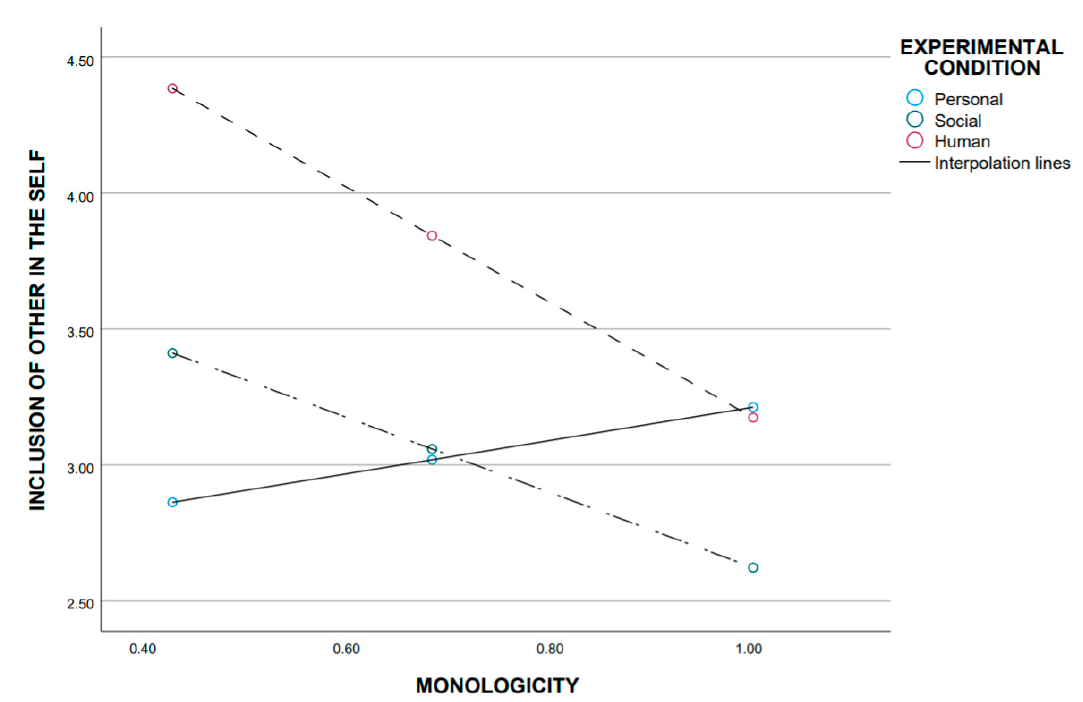
Figure 2. Scatterplot of the relations between monologicity (square root) and inclusion of the Other in the Self for each experimental condition. Note: experimental condition 1 = personal level of inclusiveness; experimental condition 2 = social level of inclusiveness; and experimental condition 3 = human level of inclusiveness.